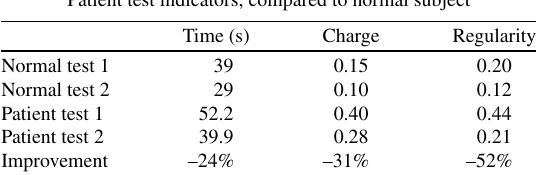
Table 1 Patient test indicators, compared to normal